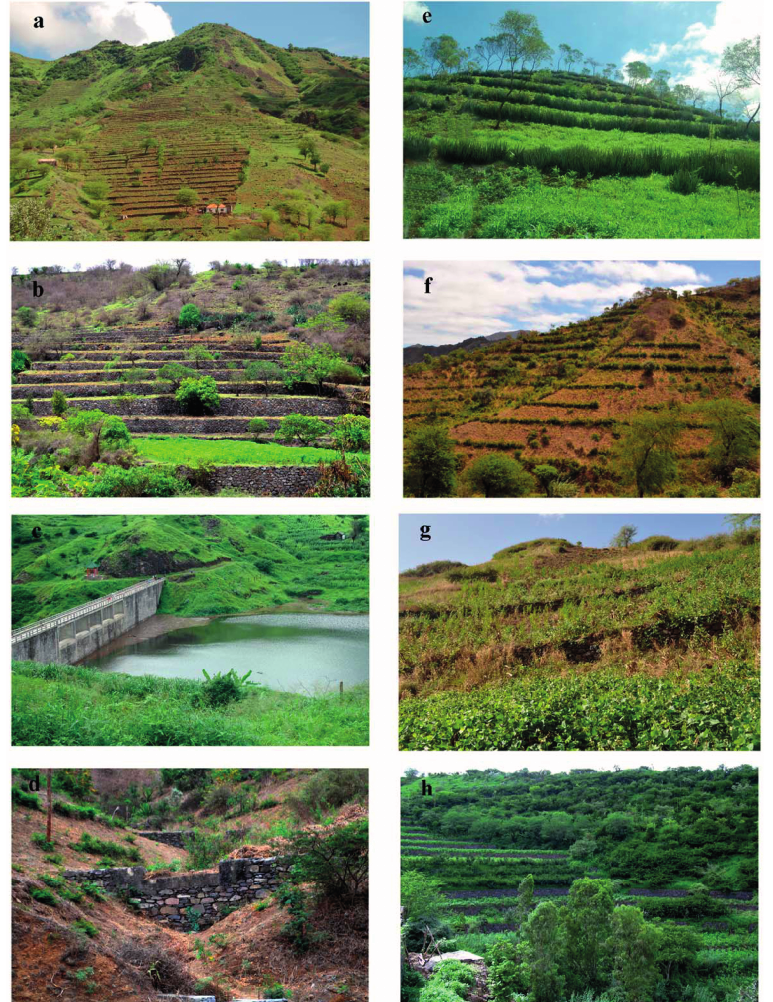
Figure 6. Vegetation and structural soil and water conservation measures in the Ribeira Seca Watershed: ( a ) contour rock walls; ( b ) terraces (São Jorge); ( c ) Water collecting dam (Poilão) during rainy season, d. check dams on water ways (Godim); (e ) Aloe Vera barriers (São Jorge), ( f ) L. Leucocephala hedges (Godim); ( g ) Pigeon-pea on terraced fields; and ( h ) Afforestation with different species ( Longueira Baixo